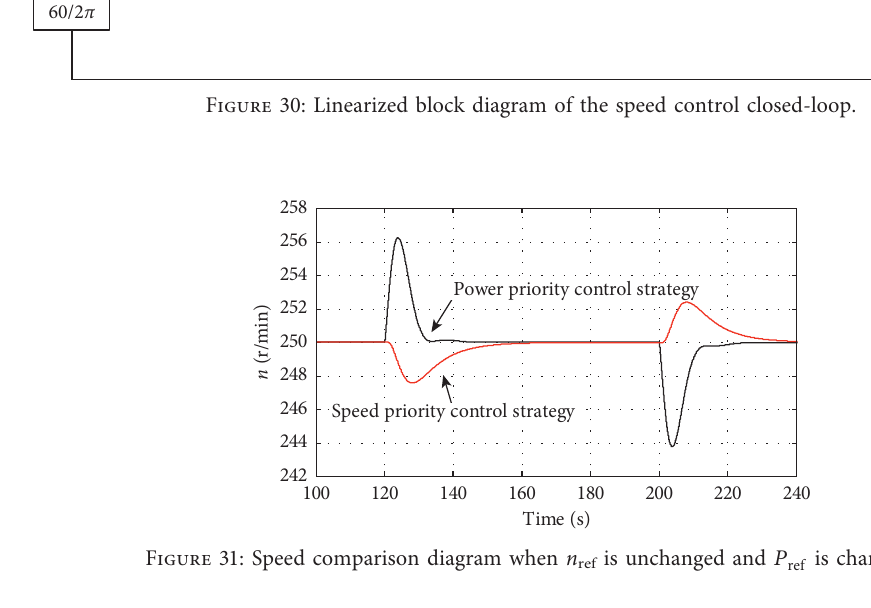
ref is unchanged and